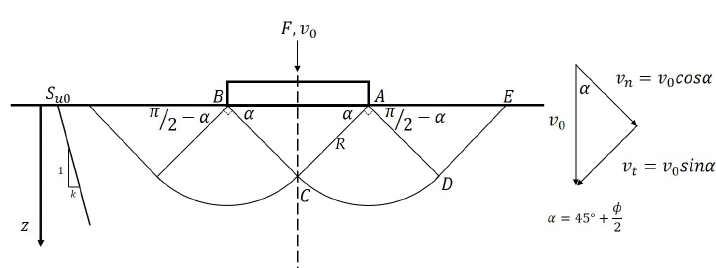
Figure 6. Velocity field with a radial zone for a perfectly rough footing on homogeneous cohesive soil [2].